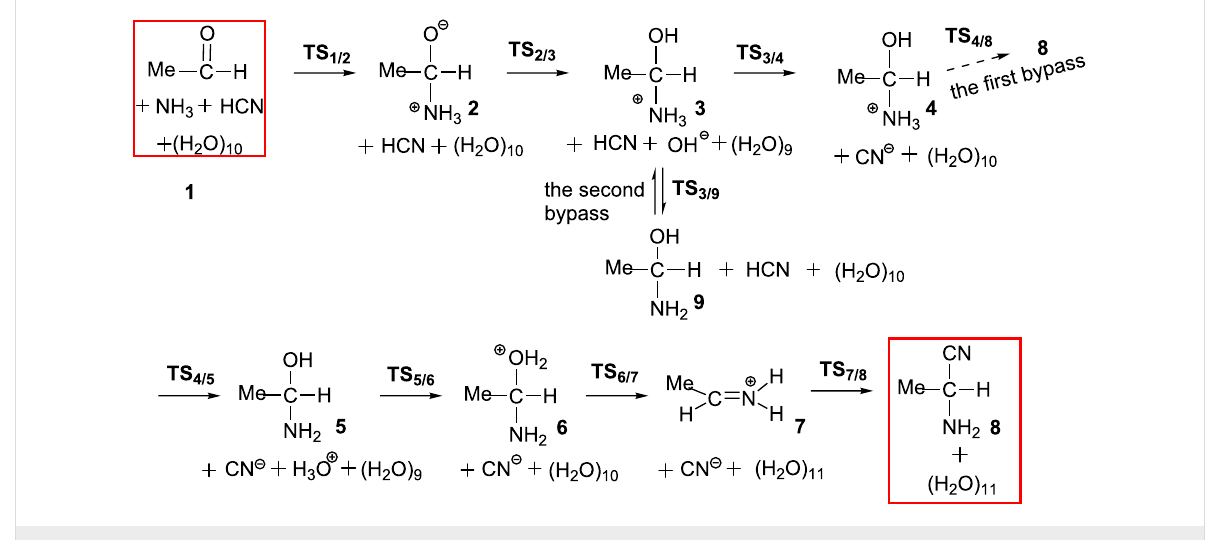
Scheme 5: Possible pathways for the formation of aminonitrile from acetaldehyde.